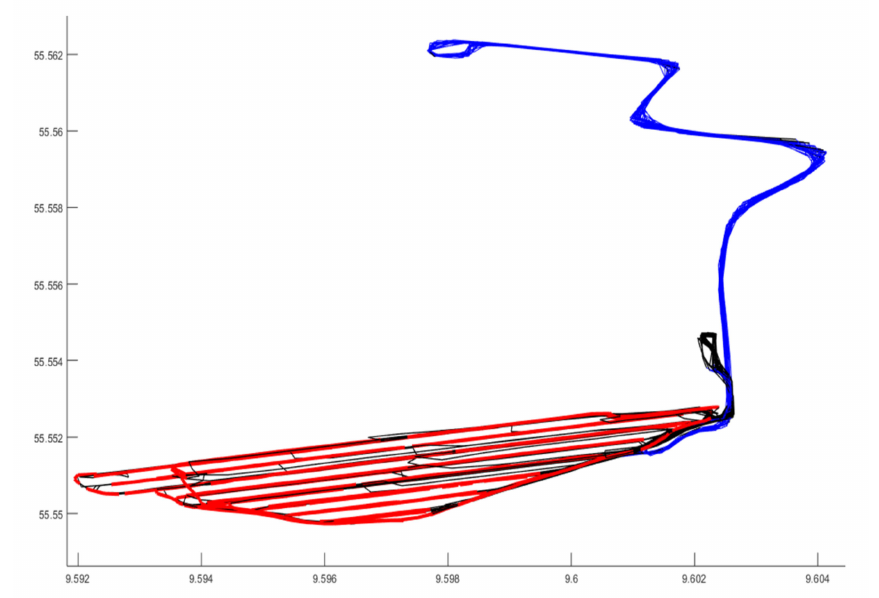
Figure 6. Sample field 1 with the conventional